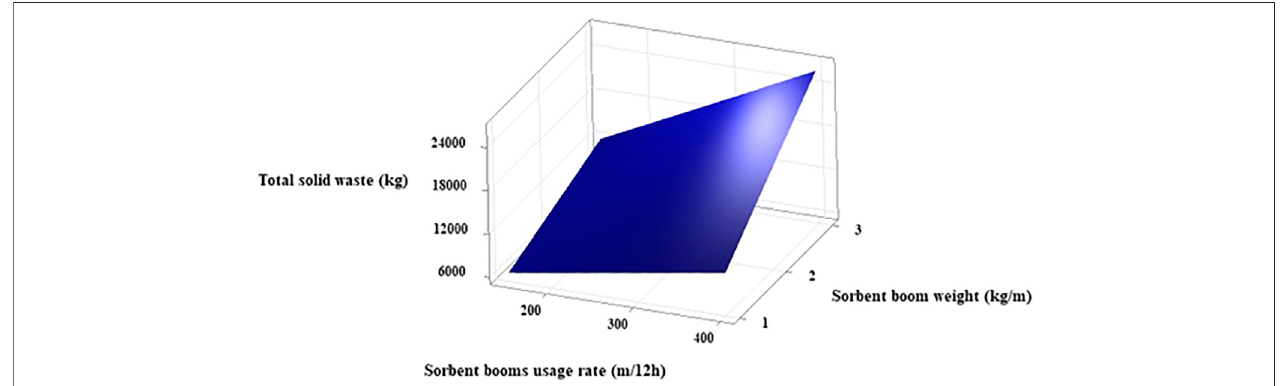
FIGURE4| Acontour plotforthe estimation oftotal solidwaste (kg) based ontheinteractionofsorbentbooms usagerate(m/12 h)and sorbentboom weight (kg/ m) in the Bella Bella oil spill.